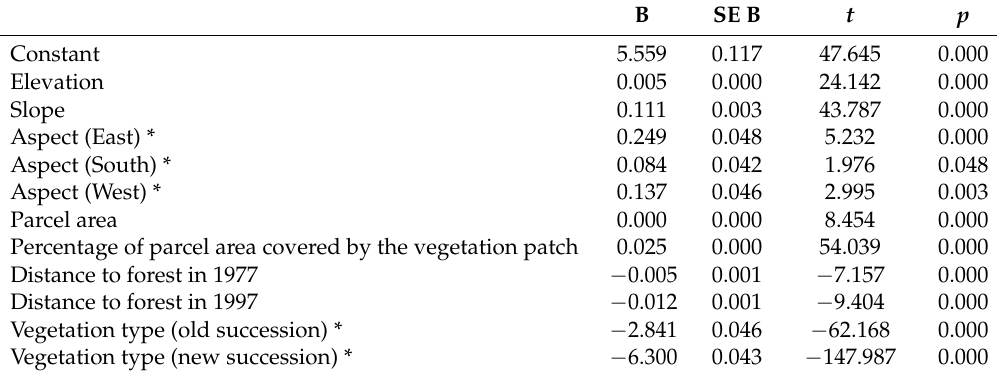
Regression results for stable forest, old and new succession vegetation height; the unstandardized beta (B), the standard error for the unstandardized beta (SE B), the t test statistic ( t ), and the probability value ( p ); and, the reference categories for aspect and vegetation type are North and stable forest, respectively; * indicates categorical variables.